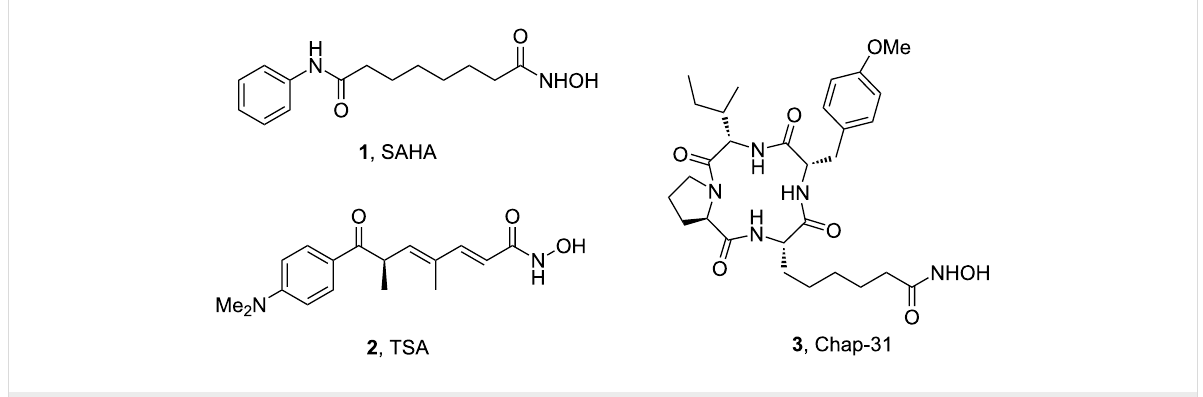
Figure 1: Some bioactive molecules containing hydroxamate functionality.